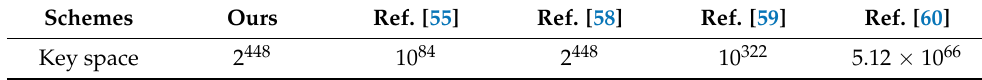
Table 3. Key space comparison.